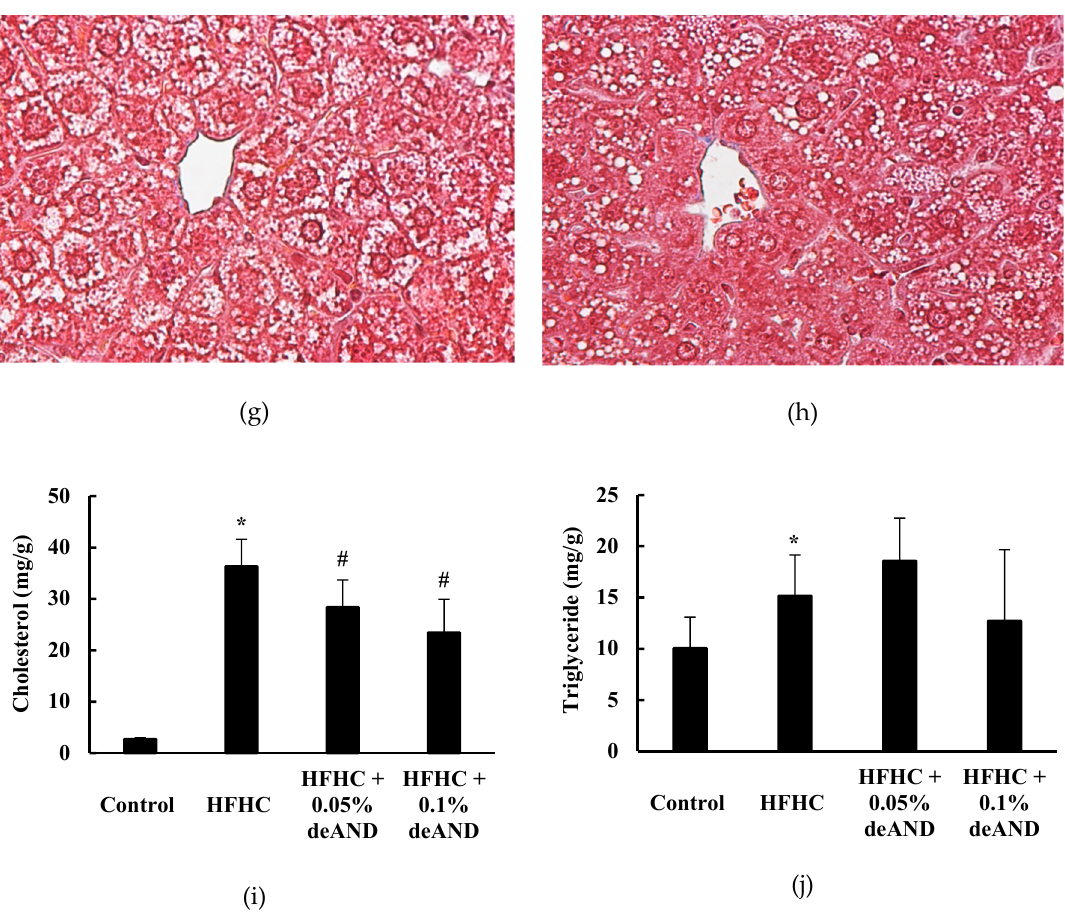
Figure 2. Histopathological examination (H&E stain, 400x) of livers in the control group ( a ), HFHC group ( b ), HFHC + 0.05% deAND group ( c ), and HFHC + 0.1% deAND group ( d ). The small arrow indicates the fat droplets and the large arrow indicates the perivenular inflammatory infiltrates. Normal liver architecture was found in the low-fat control group ( a ). Figure 2e–h shows histopathological examination of liver fibrosis (masson’s trichrome- stain, 400x) in the control group ( e ), HFHC group ( f ), HFHC + 0.05% deAND group ( g ), and HFHC + 0.1% deAND group ( h ). The large arrow in HFHC group indicates the collagen (blue color). Hepatic cholesterol and triglyceride contents are shown in ( i , j ). Values are means ± SD. ( n = 5–6). * Significantly di ff erent from the Control group, p < 0.05. # Significantly di ff erent from the HFHC group, p < 0.05. HFHC, high-fat and high cholesterol.